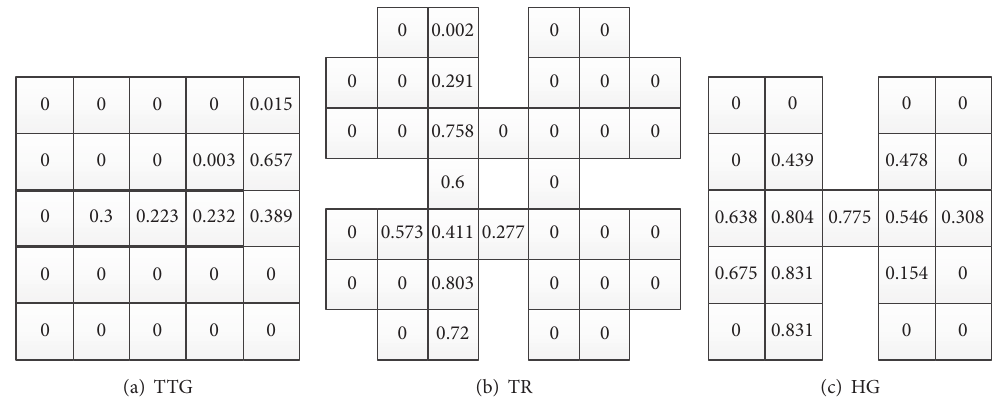
Figure 3: The computed model difference degrees in small scale games TTG, TR, and